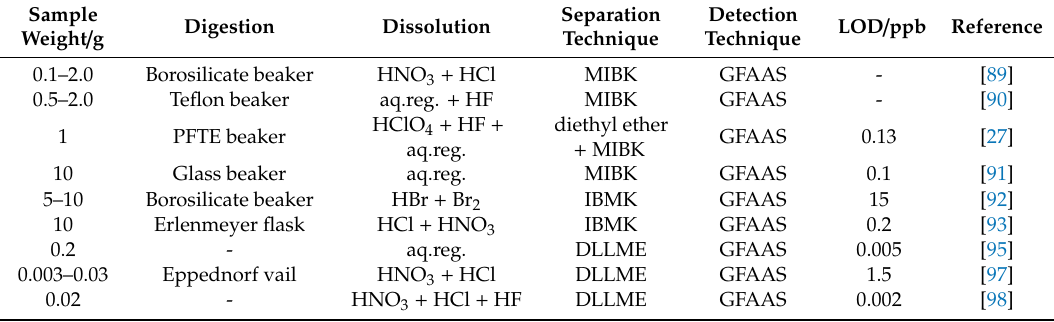
Table 5. Methods for the preconcentration of Au by solvent extraction / dispersive liquid-liquid microextraction. Sample Digestion Dissolution Weight / g